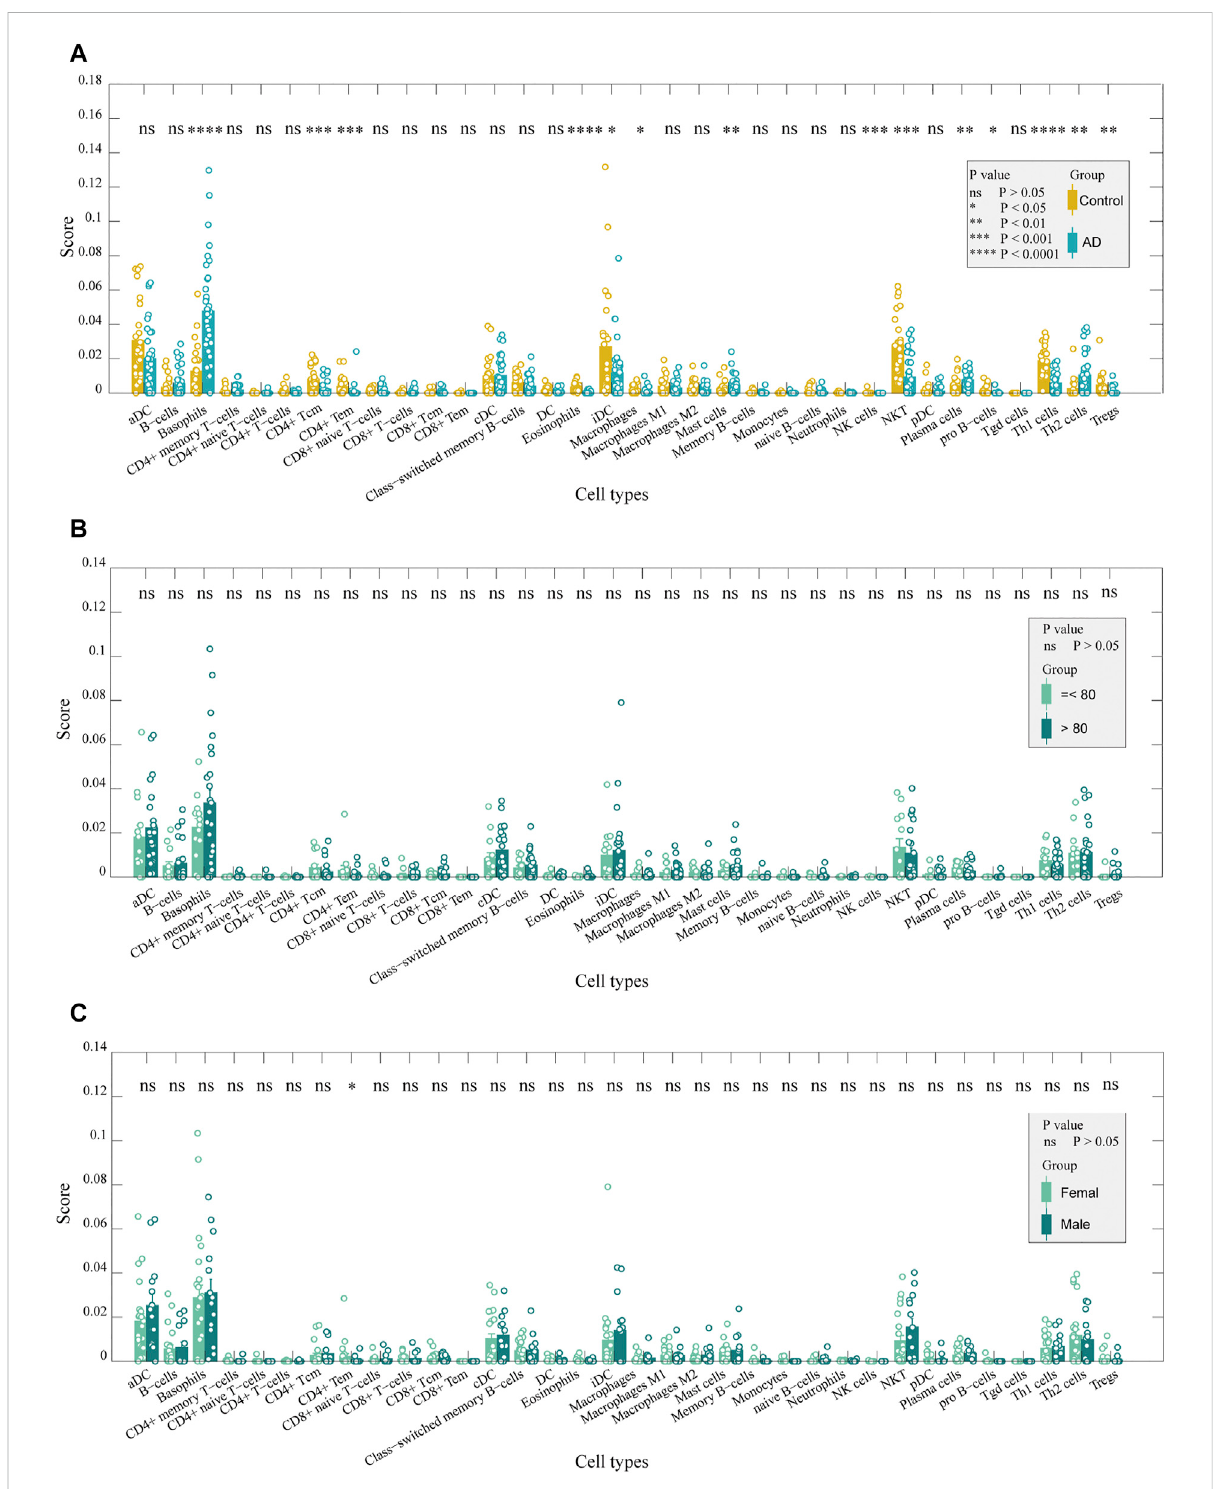
FIGURE 2 ImmunecellsintheentorhinalcortexbetweenADandcontrolsamples. (A) .ComparisonofthescoresofimmunecellsbetweenADandcontrol samples:CD4 + Tc,CD4 + Te,Th1,NK,NKT,andpro-Bcells,eosinophils,andTregsweredecreasedinADs( p < 0.05).Incontrast,basophils,mastcells, plasma cells, and macrophages had elevated scores ( p < 0.05). (B) . Comparison of immune cell scores between older and younger patients in AD samples: nosigni fi cant difference was detected. (C) .Comparisonof thescore ofimmunecells between femalesandmalesinAD samples: only CD4 + Tem was signi fi cantly different between the two groups ( p <